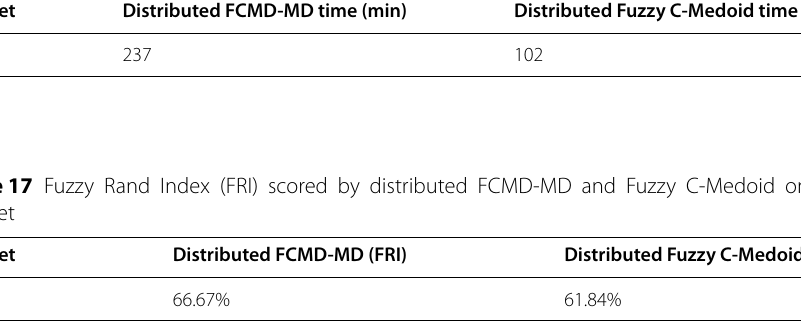
Table 16 Convergence time of distributed FCMD-MD and Fuzzy C-Medoid on OSI dataset Dataset